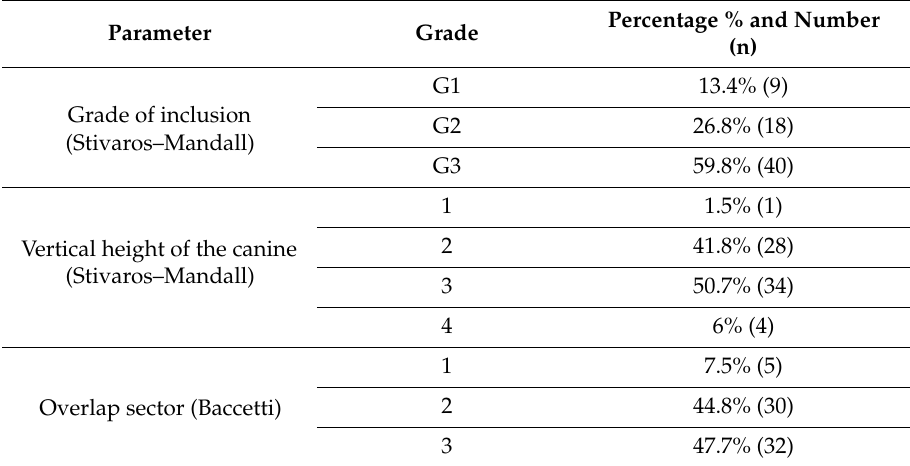
Table 2. Descriptive results of the test